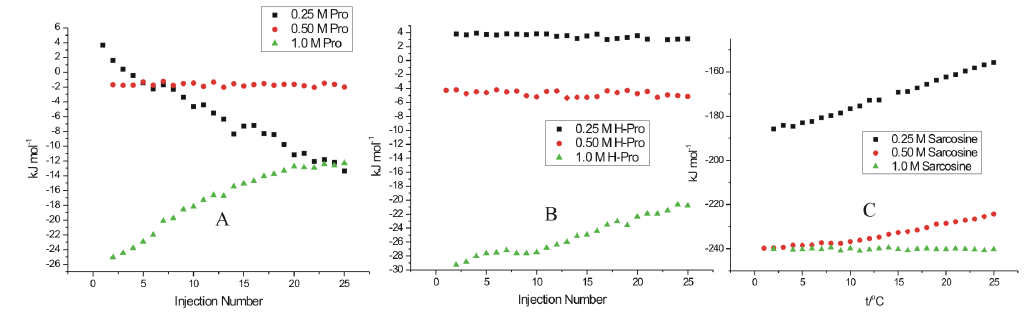
Figure 7. ITC profiles for the titrations of lysozyme solution at elongation stage (after 61 h of incubation) with (A) L-proline (B) 4- hydroxy-L-proline and (C) sarcosine at 25 6 C.